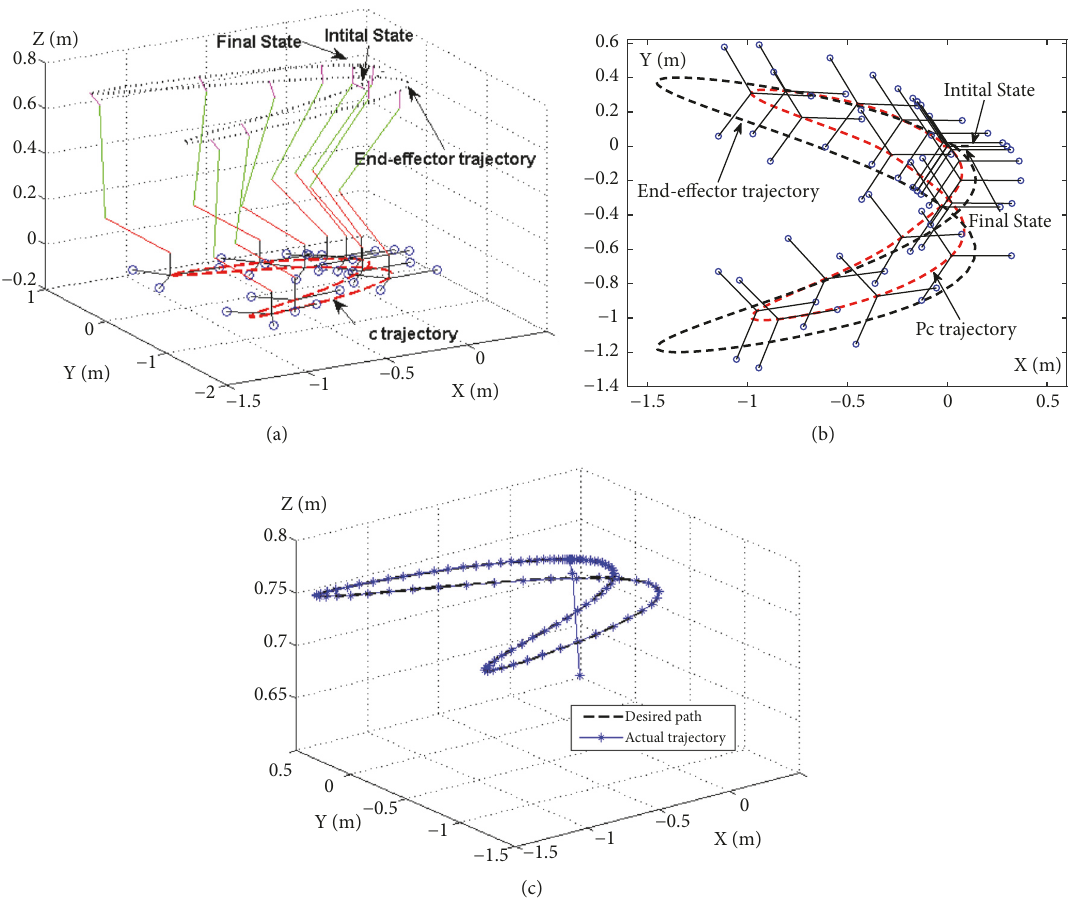
Figure 8: Lissajous path tracking profiles synthesized by TTZNN model (27). (a) Trajectories for the mobile manipulator. (b) Vertical view for the three-wheel mobile manipulator. (c) Lissajous tracking profiles of the end-effector.